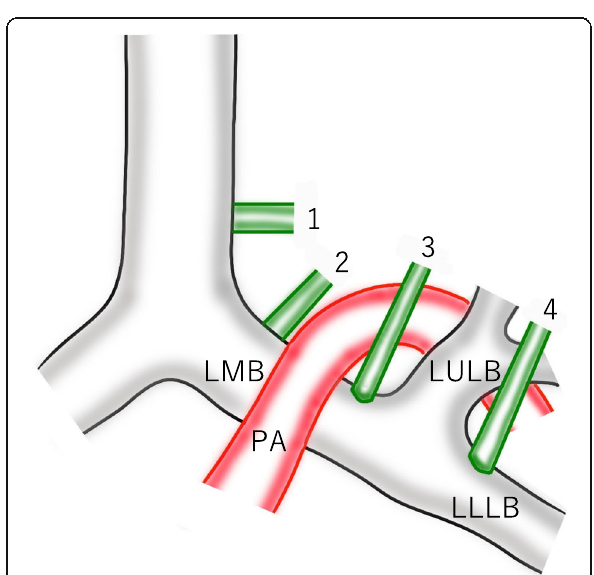
Fig. 5 Schema of aberrant bronchi to the left upper lobe. Ghaye et al. classified them as follows: (1) eparterial (true left tracheal) bronchi; (2) eparterial (left “ tracheal ” ) bronchi; (3) prehyparterial bronchi; and (4) posthyparterial bronchi. LMB, left main bronchus; PA, pulmonary artery; LULB, left upper lobe bronchus; LLLB, left lower lobe